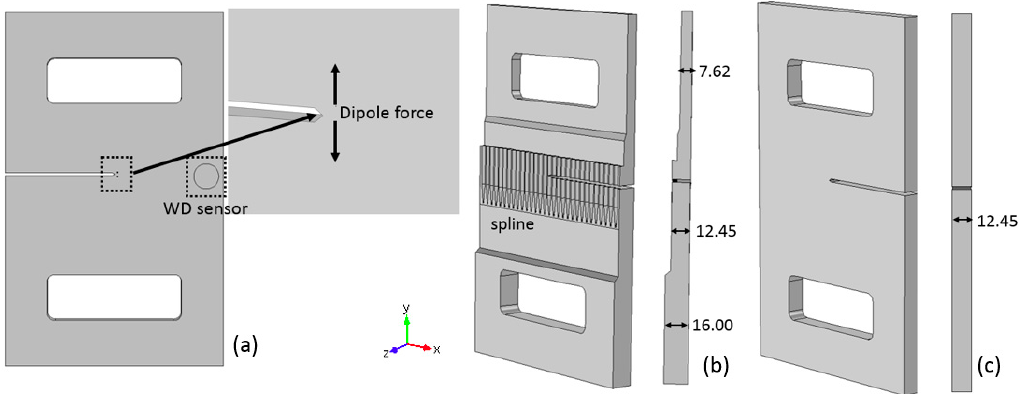
Figure 3. The schematics of numerical models to study the influence of geometric details on AE signatures; ( a ) excitation and sensor; ( b ) simple model; and ( c ) complex model (unit: mm).